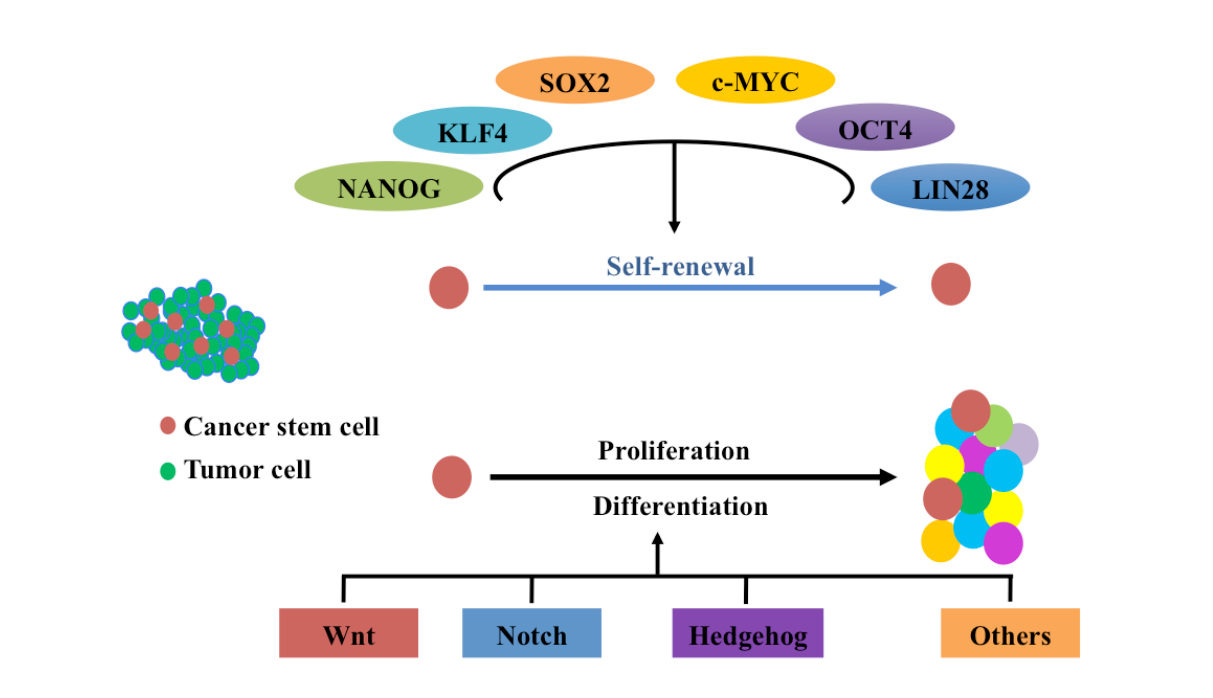
Figure 1. A schematic representation of key transcription factors and molecular signaling pathways involved in